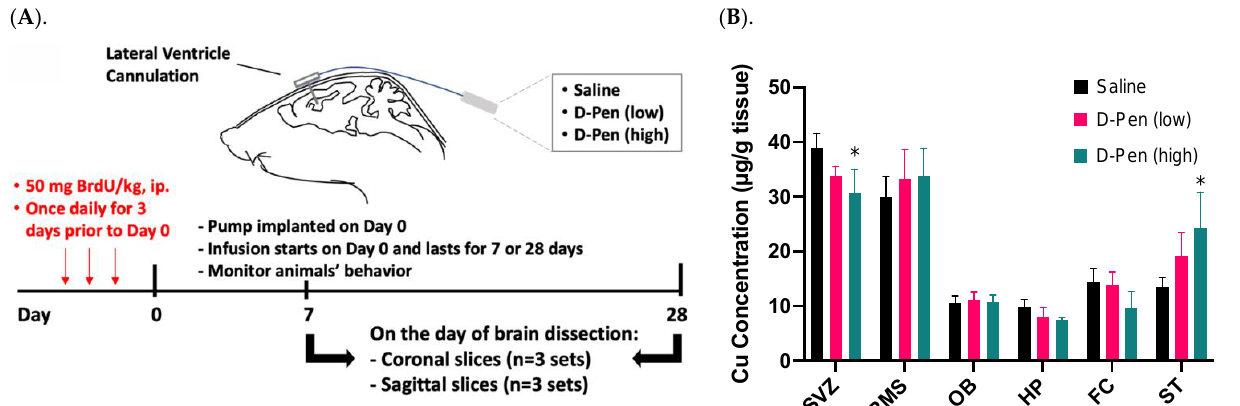
Figure 6. ICV experimental approach in mice and Cu concentrations in brain regions after short/long term D-Pen infusion. ( A ) A graphical illustration of the experimental design. Mice received ICV infusion of saline or D-Pen (0.075 µ g/h or 0.75 µ g/h) for 7 days (short term) or 28 days (long term). ( B ) Quantification of brain Cu concentrations by AAS in SVZ, RMS, OB, hippocampus (HP), frontal cortex (FC), and striatum (ST). Data represent mean ± SD, n = 3/group. * p < 0.05 as compared with the controls infused with saline.